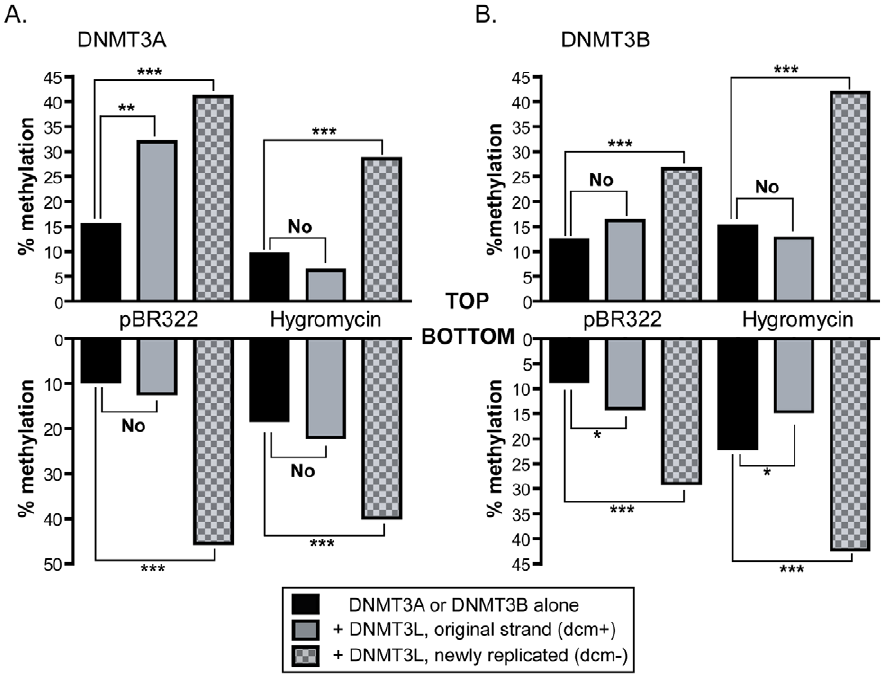
Figure 7. Stimulation by DNMT3L is observed primarily on newly replicated DNA strands. The overall methylation efficiencies (in percentages) observed on both strands at the pBR322 and Hygro regions are indicated in black bars for DNMT3A (panel A) and DNMT3B (panel B). The number of independent DNA molecules taken into account to calculate the average methylation efficiencies varied from 36 molecules to 120 per sample. In the presence of DNMT3L, the data were broken down between dcm + (grey bars) and dcm 2 (checkered grey bars) DNA strands, as indicated. Whether the stimulation afforded by DNMT3L was significant or not was determined by a one tailed Student t-test and is indicated graphically (‘no’, not significant; ‘***’ P-value , 0.001; ‘**’ P-value between 0.001 and 0.01; ‘*’ P-value between 0.01 and 0.05). While DNMT3L-mediated stimulation of DNA methylation is readily observed at all tested regions on newly synthesized DNA molecules (dcm 2 ), it is not observed in the majority of cases for dcm +